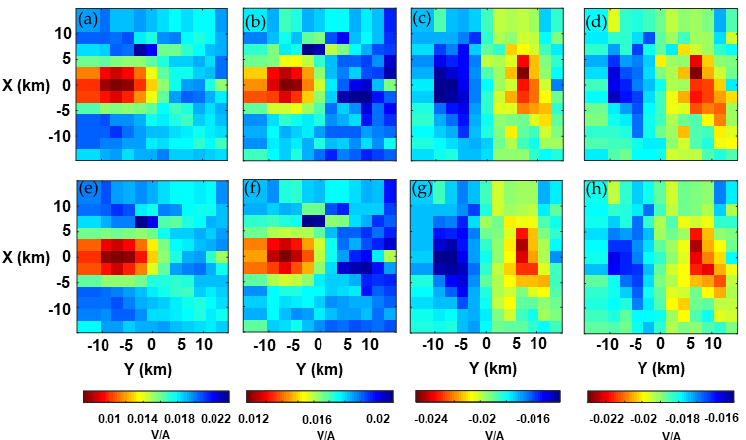
Figure 22. Data fitting for Z xy and Z yx components at the frequency of 0.285 Hz. Panels ( a ) and ( b ) show the real and imaginary parts of observed Z xy component. Panels ( c ) and ( d ) show the real and imaginary parts of the observed Z yx component. Panels ( e ) and ( f ) show the real and imaginary parts of the predicted Z xy component. Panels ( g ) and ( h ) show the real and imaginary parts of the predicted Z yx component.